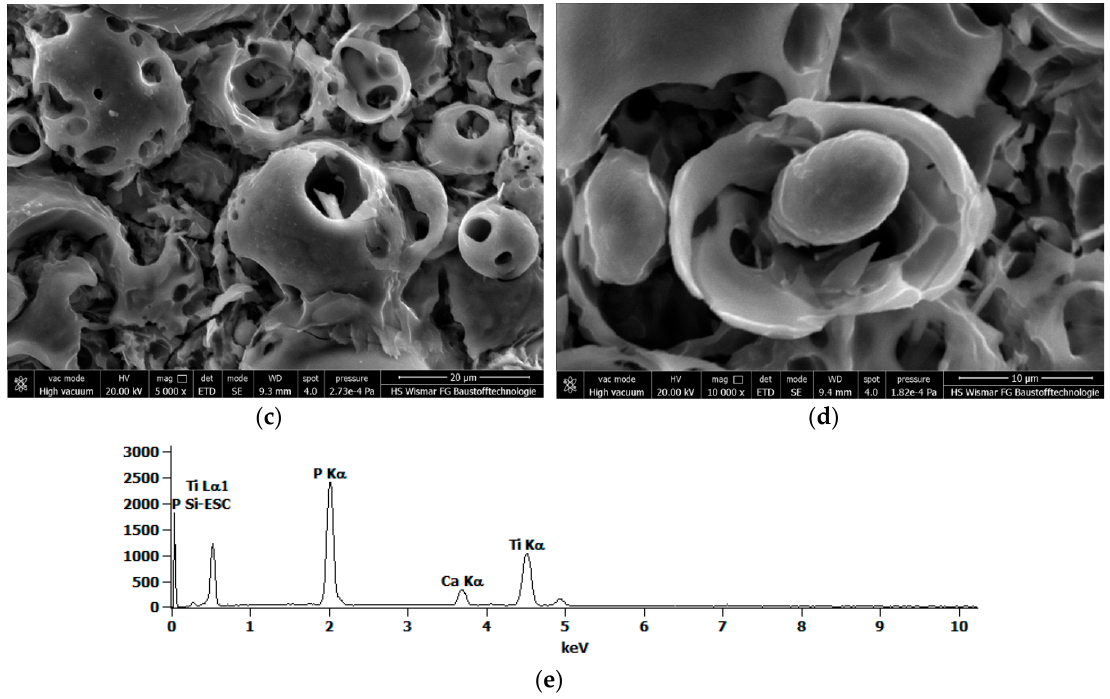
Figure 5 . SEM pictures ( a – d ) and EDS spectrum ( e ) of the porous coating formed on CP Titanium Grade 2 after PEO treatment at a voltage of 450 V DC in 500 g Ca(NO 3 ) 2 · 4H 2 O in 1000 mL H 3 PO 4 electrolyte. Magnifications: ( a ) 500×, ( b ) 1000×, ( c ) 5000×, ( d ) 10,000×.